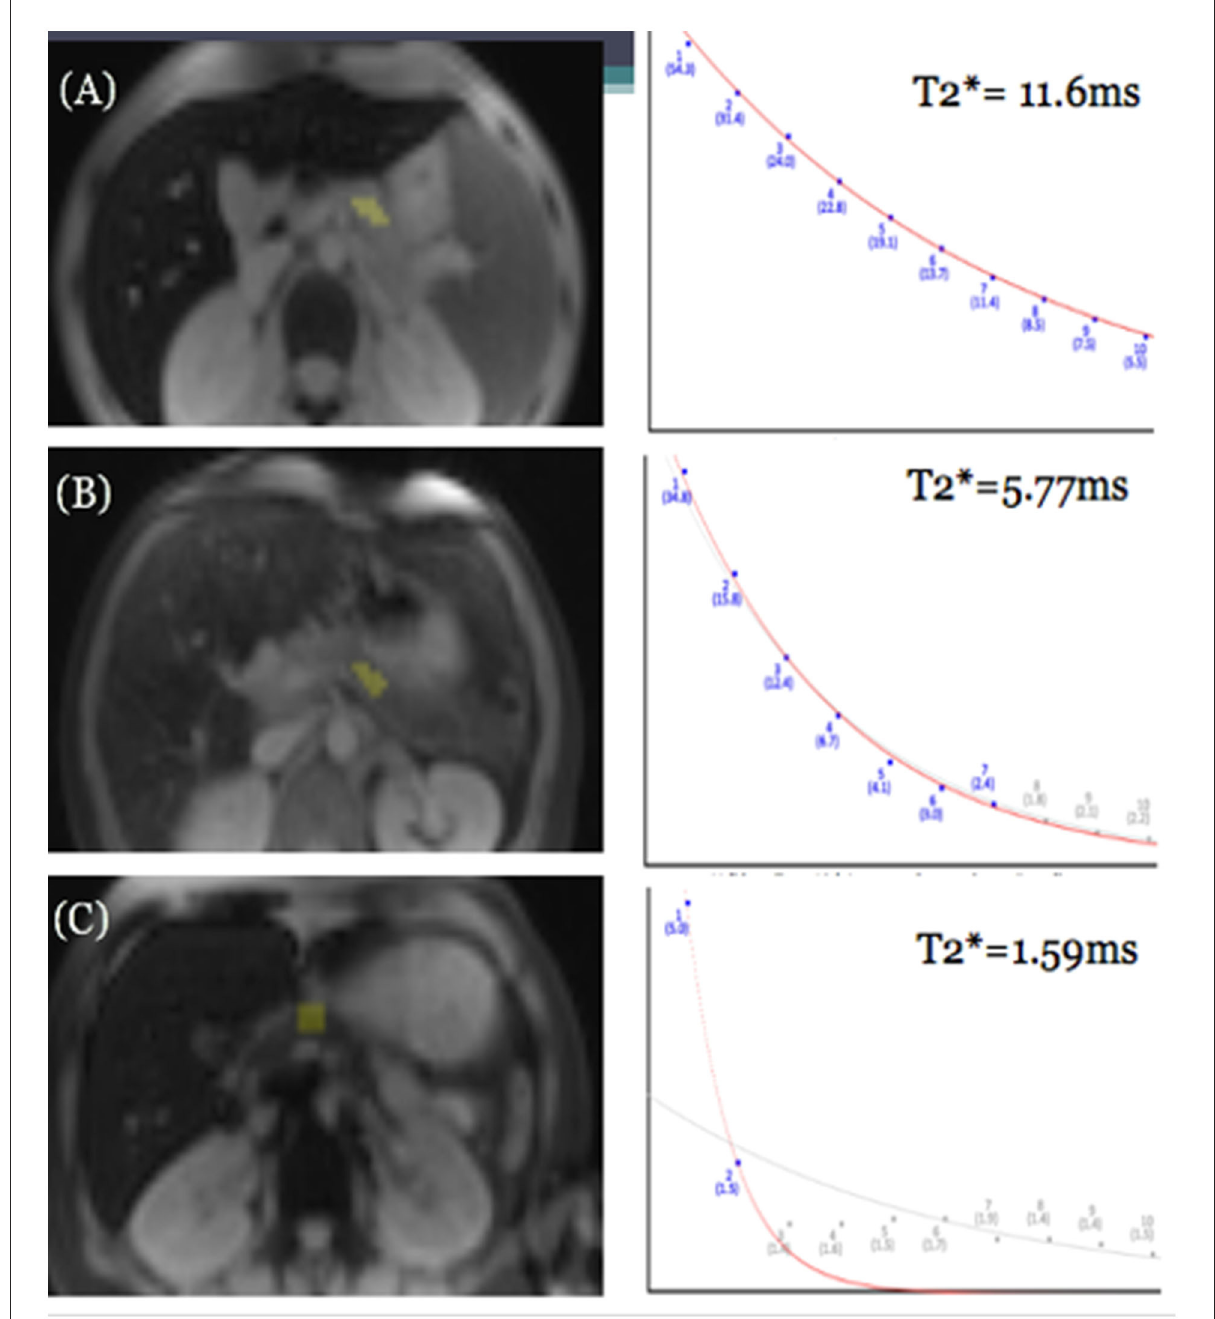
FIGURE1 GRE MRI images of three different patients showing mild (A) , moderate (B) , and severe (C) iron deposition in the pancreas at the level of the splenic vein, and corresponding differences in rate of signal decay resulting in different pancreatic T2* values in patients with mild, moderate, and severe pancreatic iron